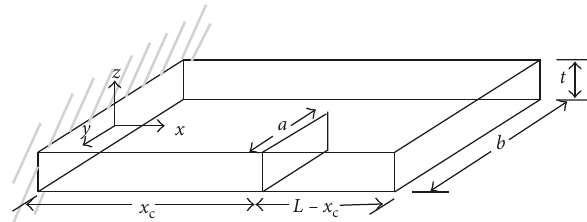
Figure 1: Geometry of a laminated cracked composite